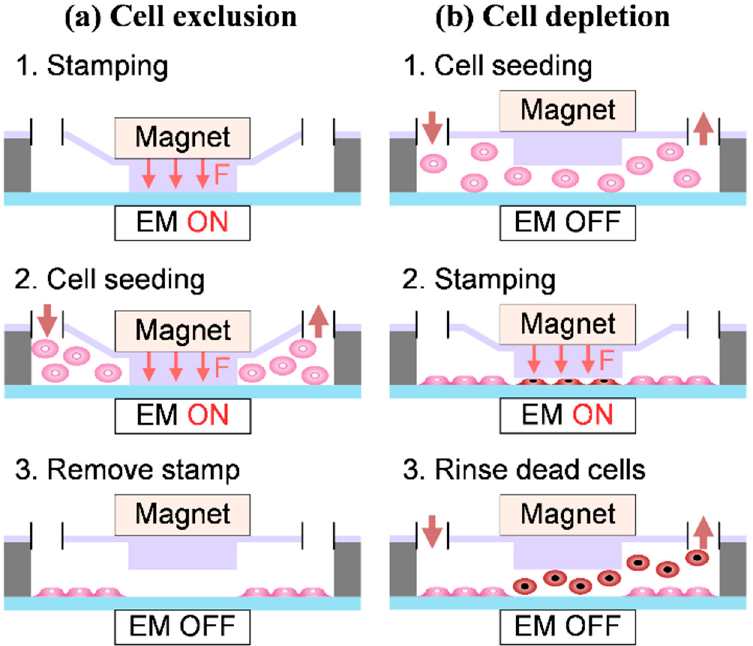
Figure 6. Schematic illustrations of the principles of ( a ) cell exclusion and ( b ) cell depletion in our system. The magnet represents the magnet and the stamp underneath it for the sake of understanding. The switch of the electromagnet module (EM) is controlled by Arduino.